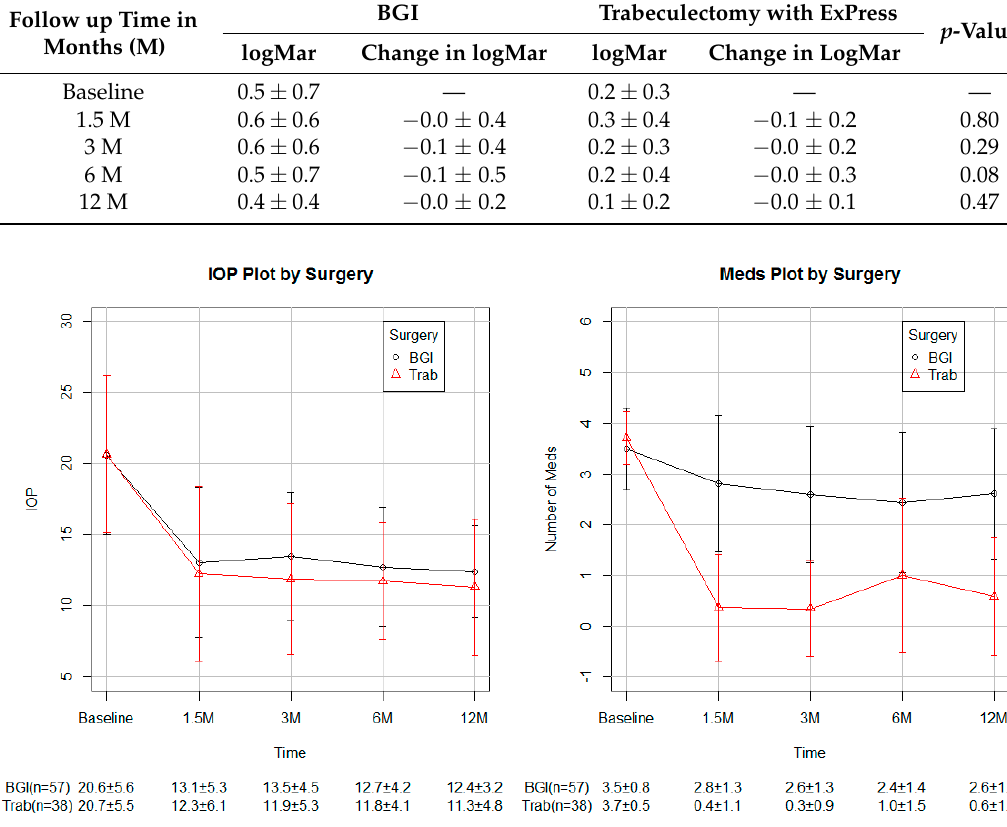
Figure 3. IOP and number of medications in each group (Mean ± SD).